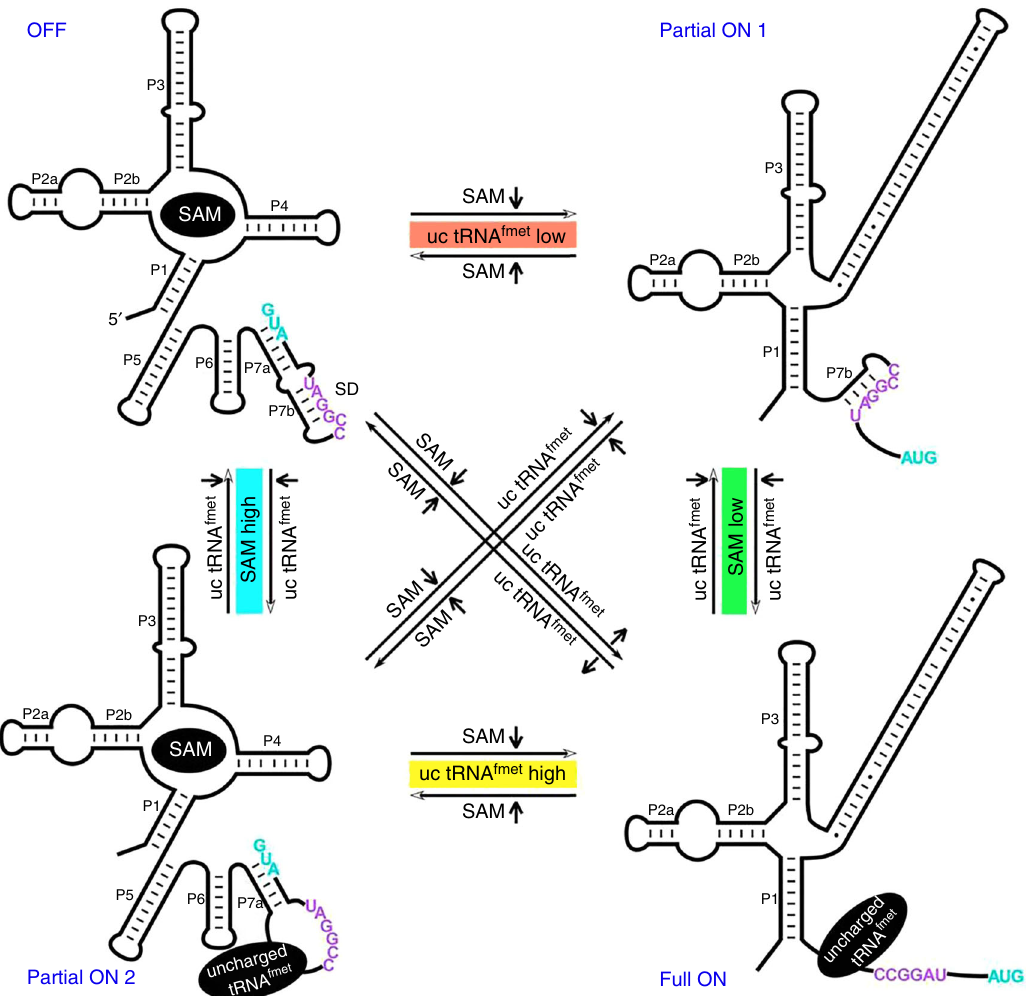
Fig. 6 A proposed working model for SAM-I Xcc riboswitch. Upon sensing the fl uctuation of SAM and uncharged (uc) tRNA fMet , the riboswitch could change its con fi guration among four states: OFF, Partial ON 1, Partial ON 2, and